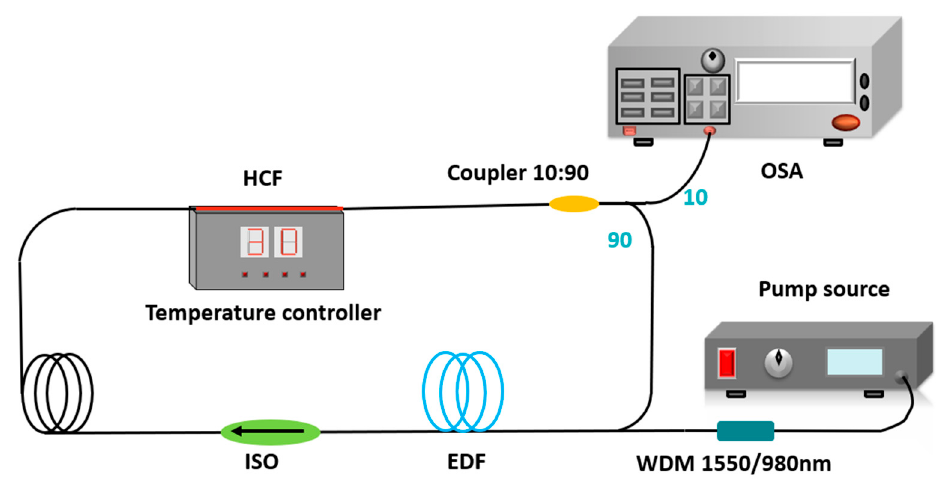
Figure 5. The schematic configuration of the proposed FRL temperature sensor system.